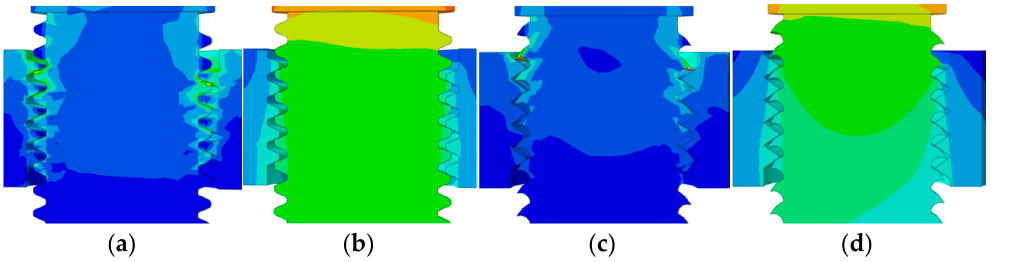
Figure 14. The bolt simulation stress S and displacement U of thread tooth deformation. ( a ) C1-S;